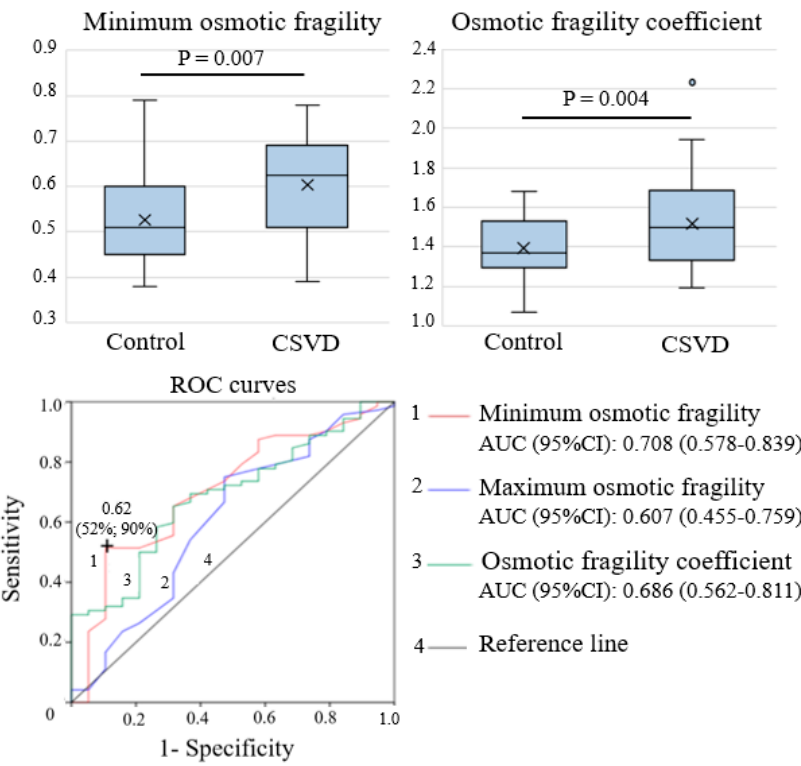
Figure 2. Comparison of the osmotic fragility parameters between patients with CSVD and the control group. ROC curves of osmotic fragility parameters in relation to CSVD development are shown.